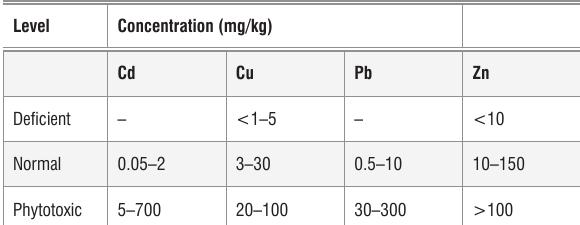
Table 3: Typical concentrations of heavy metals in plants at deficient, normal and phytotoxic levels Level Concentration (mg/kg) Cd Cu Pb Zn Deficient – <1–5 – <10 Normal 0.05–2 3–30 0.5–10 10–150 Phytotoxic 5–700 20–100 30–300